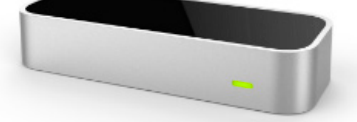
Figure 2. The Leap Motion Controller.